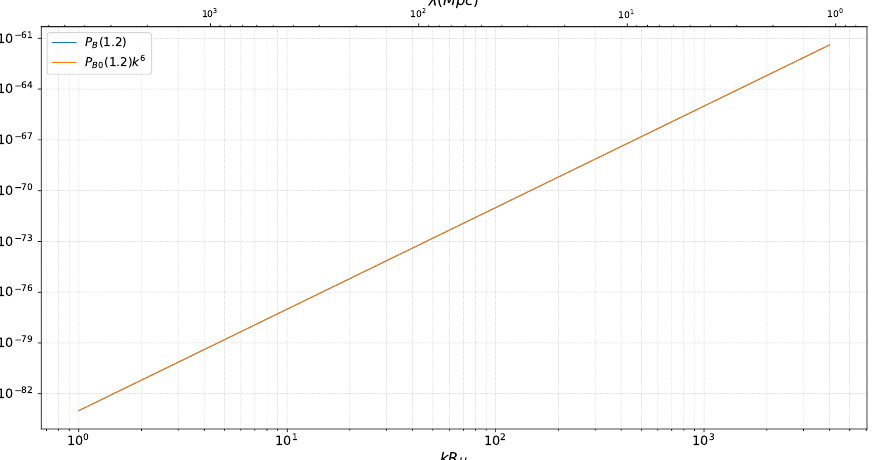
Figure 12. Behavior of the magnetic power spectrum today from (155) (blue) for C = 10 23 and x b = 10 30 . It is perfectly compatible with a power-law with spectral index n B =